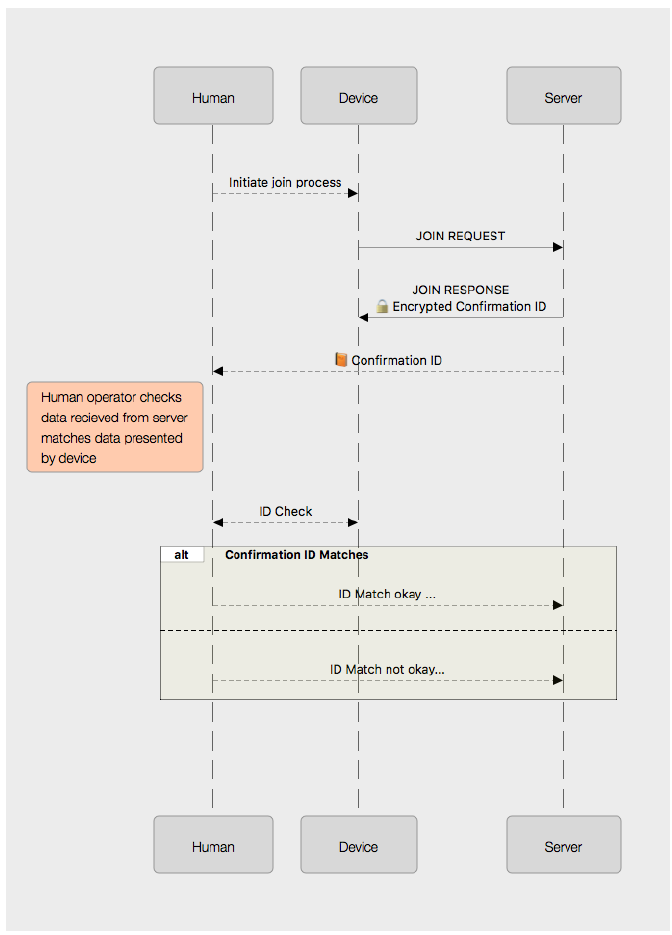
Figure 1. The sequence of a human-in-the-loop join